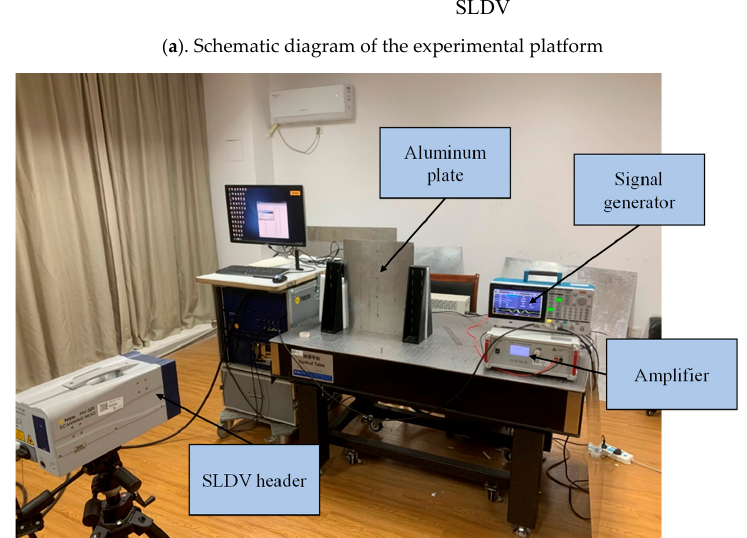
Figure 18. Scanning Laser Doppler Vibrometer scanning point location. Figure 19 shows the area division on the back of the aluminum plate, which is divided into nine rectangular regions of 133.3 × 166.7 mm 2 . Similar to Section 4, two sets of test sets with different locations are also set to check out the model’s forecasting ability. The